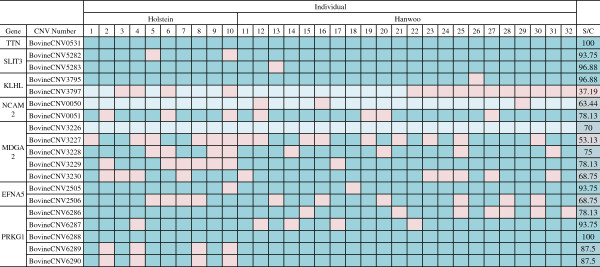
CNV validation and its accuracy measure by gDNA PCR. The CNV pattern comparison in 32 individuals was represented by a heat map. The colors of the boxes represent whether the genotypes resulting from PCR matched the predicted genotypes by Genome STRiP. Dark blue indicates that that the two matched while pink indicates that the two did not match. Sky-blue boxes represent restricted matching with the CNV showing only deleted or non-deleted allele in the PCR validation. The average matching rate of the CNVs, 80.02%, was considered to be the CNV accuracy.